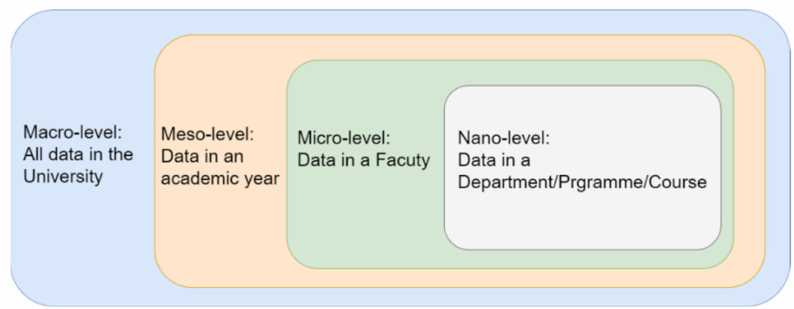
Figure 2. Overlapping of the analytics levels in this study.